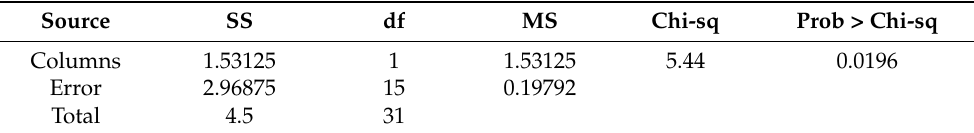
Table 16. Friedman’s ANOVA